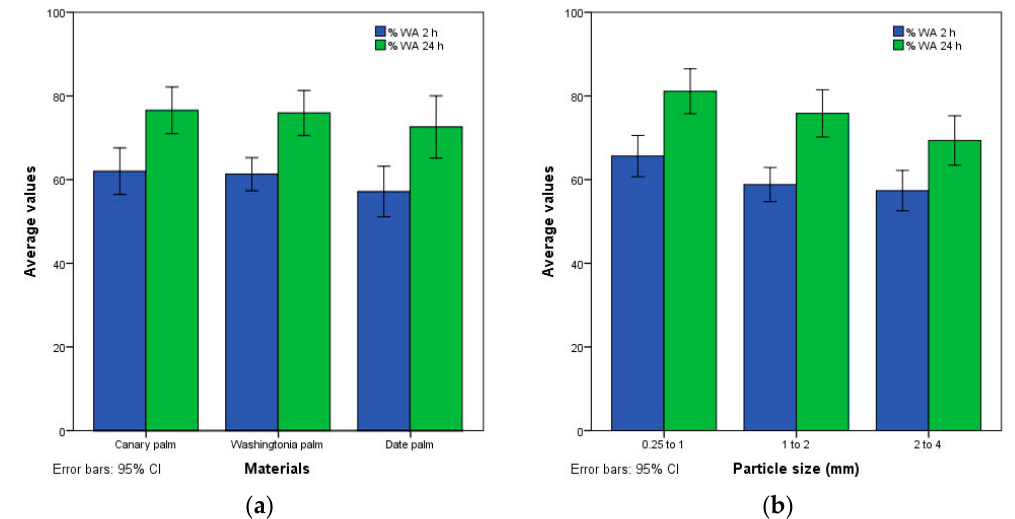
Figure 5. ( a ) Average WA values after 2 and 24 h of water immersion according to palm species. ( b ) Average WA values after 2 and 24 h of water immersion according to particle size.